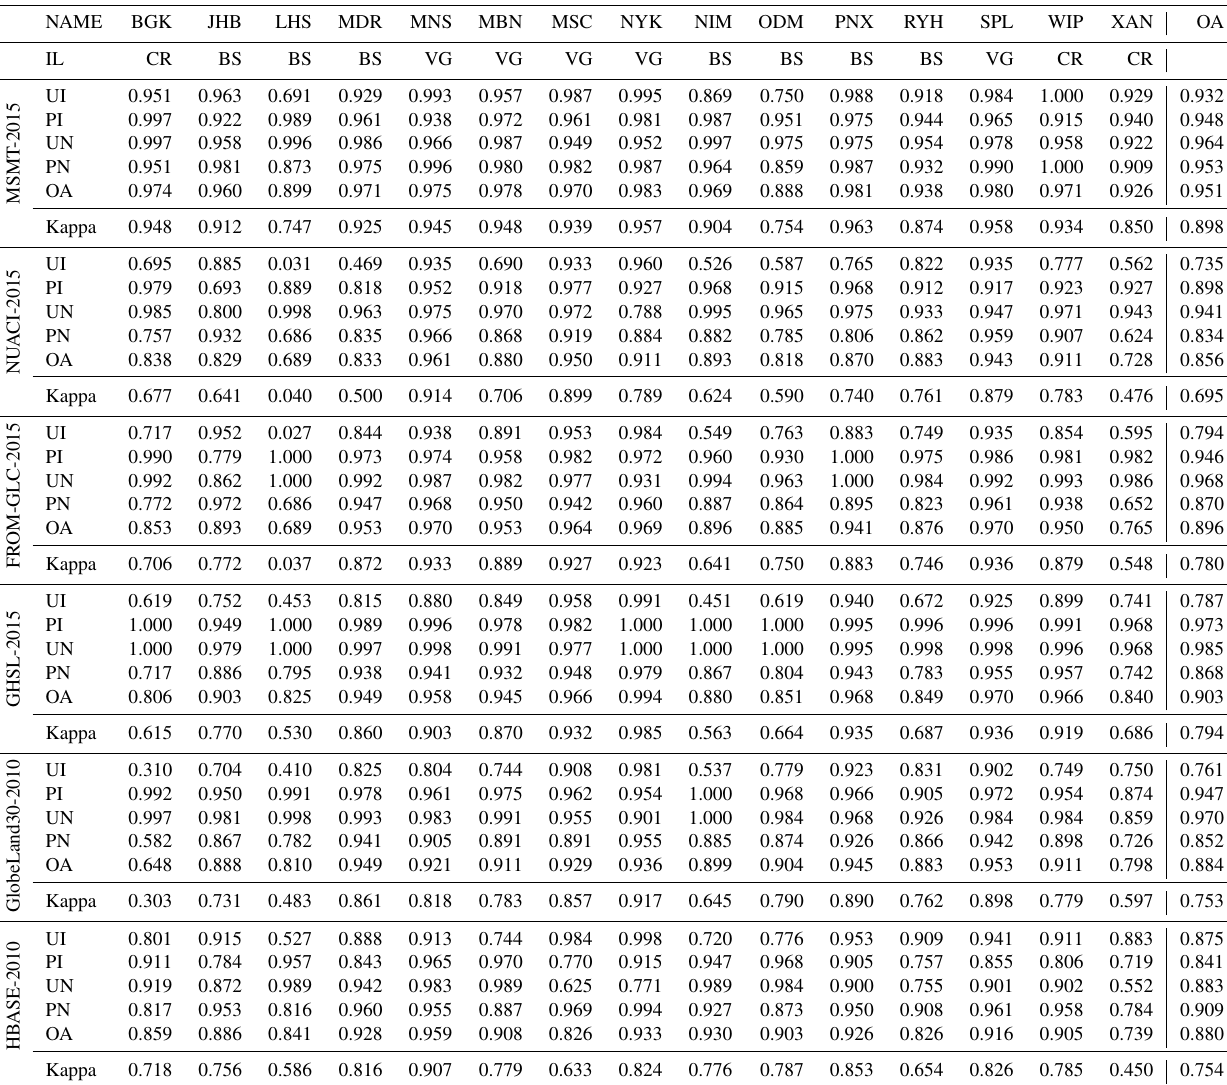
Table 2. Accuracy of the six impervious surface maps over 15 validation